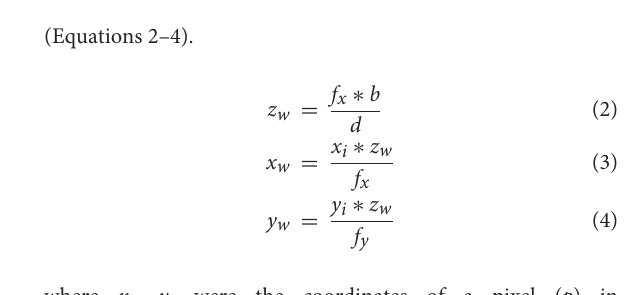
grass and wooden poles (Equation 1). The filtering thresholds were carefully tuned and verified on representative images in the